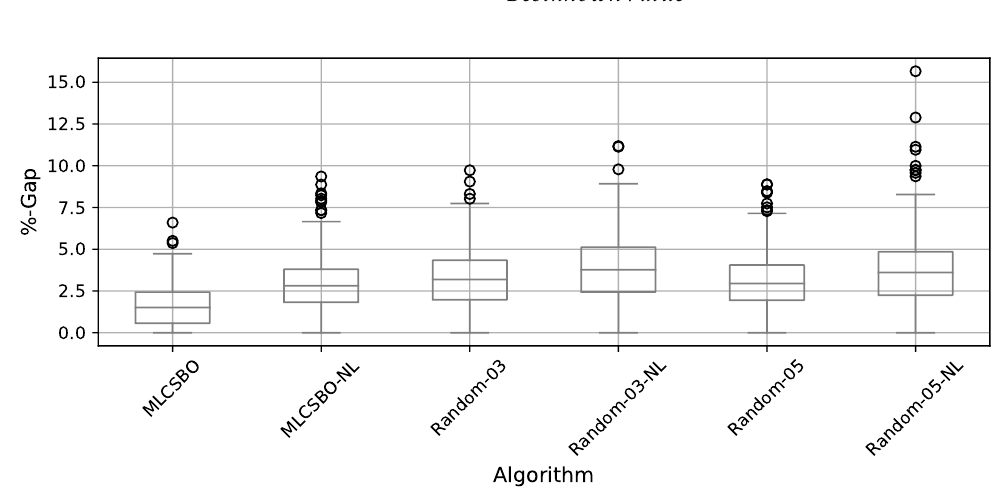
Figure 3. Box plots for MLCSBO and random operators, with and without local search